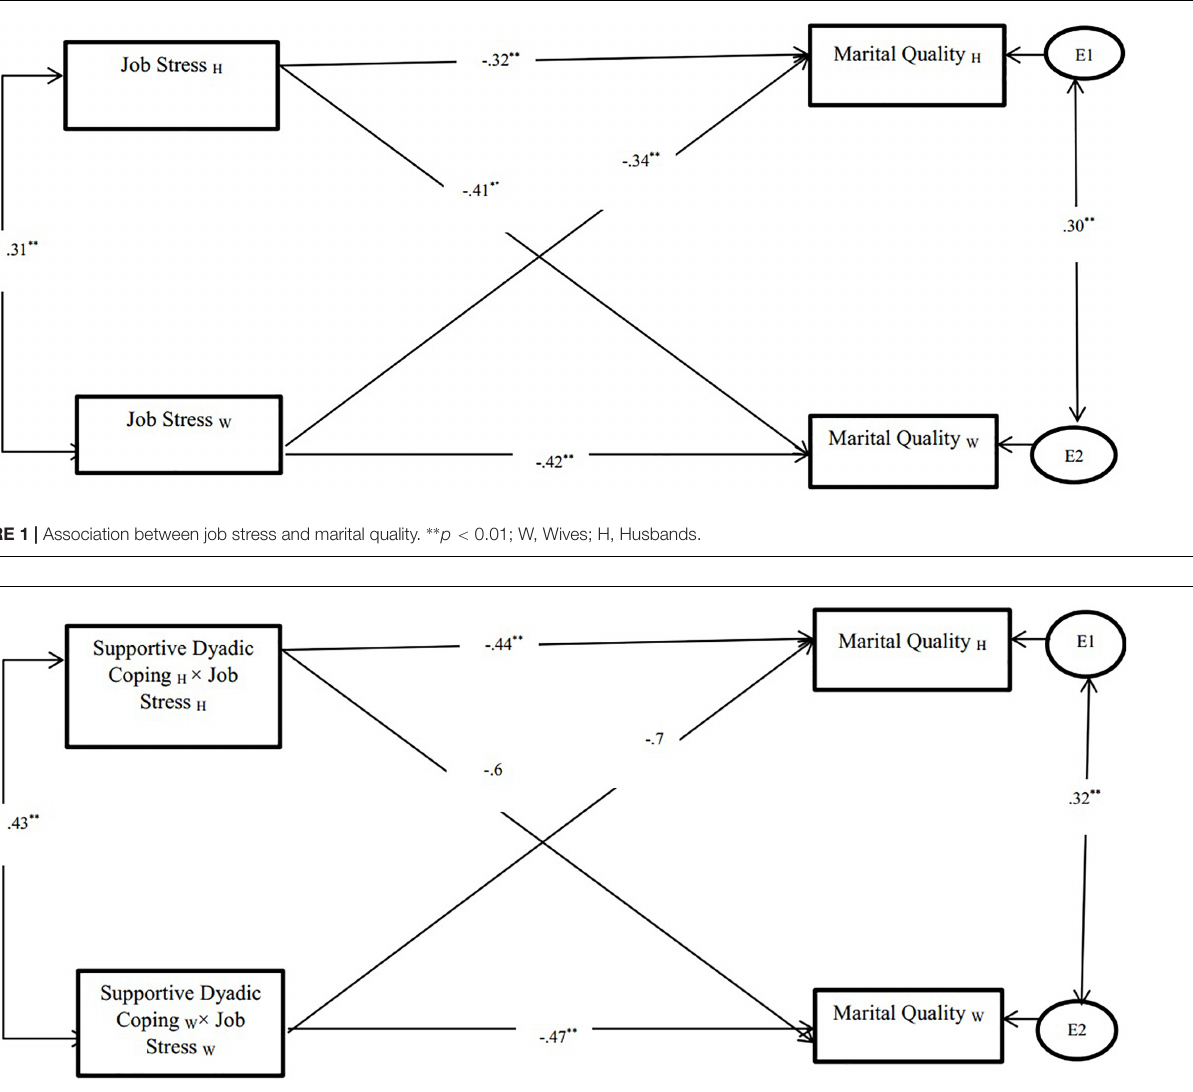
FIGURE 2 | Association between perceived partner supportive dyadic coping and marital quality. ∗∗ p < 0.01; W, Wives; H, Husbands. “Supportive dyadic coping” was measured by partner’s perception of their partner’s engagement in dyadic